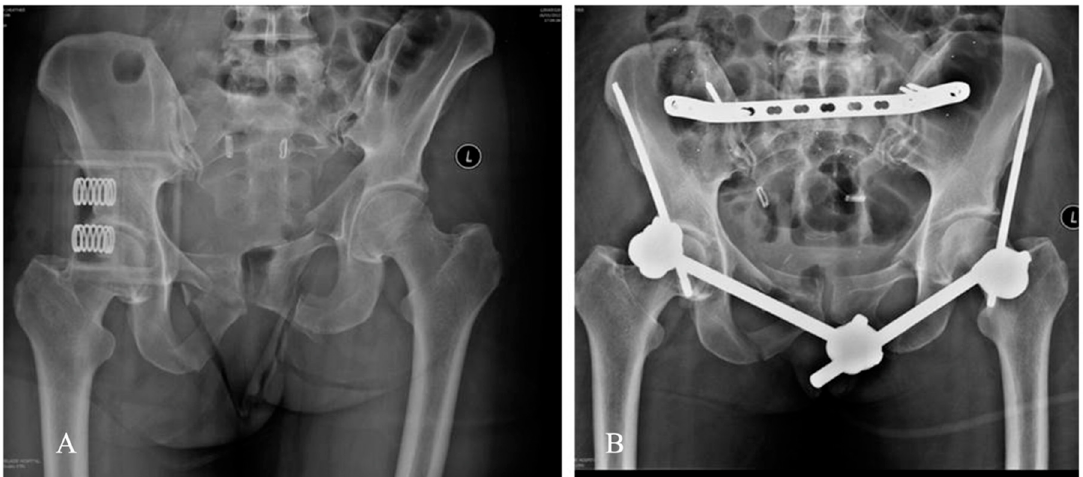
Figure 2. ( A ) AP pelvis X-ray of Patient 1 pelvic ring injury. ( B ) AP pelvic X-ray of the same pelvis after reduction and stabilised with a posterior plate and an anterior subcristal external